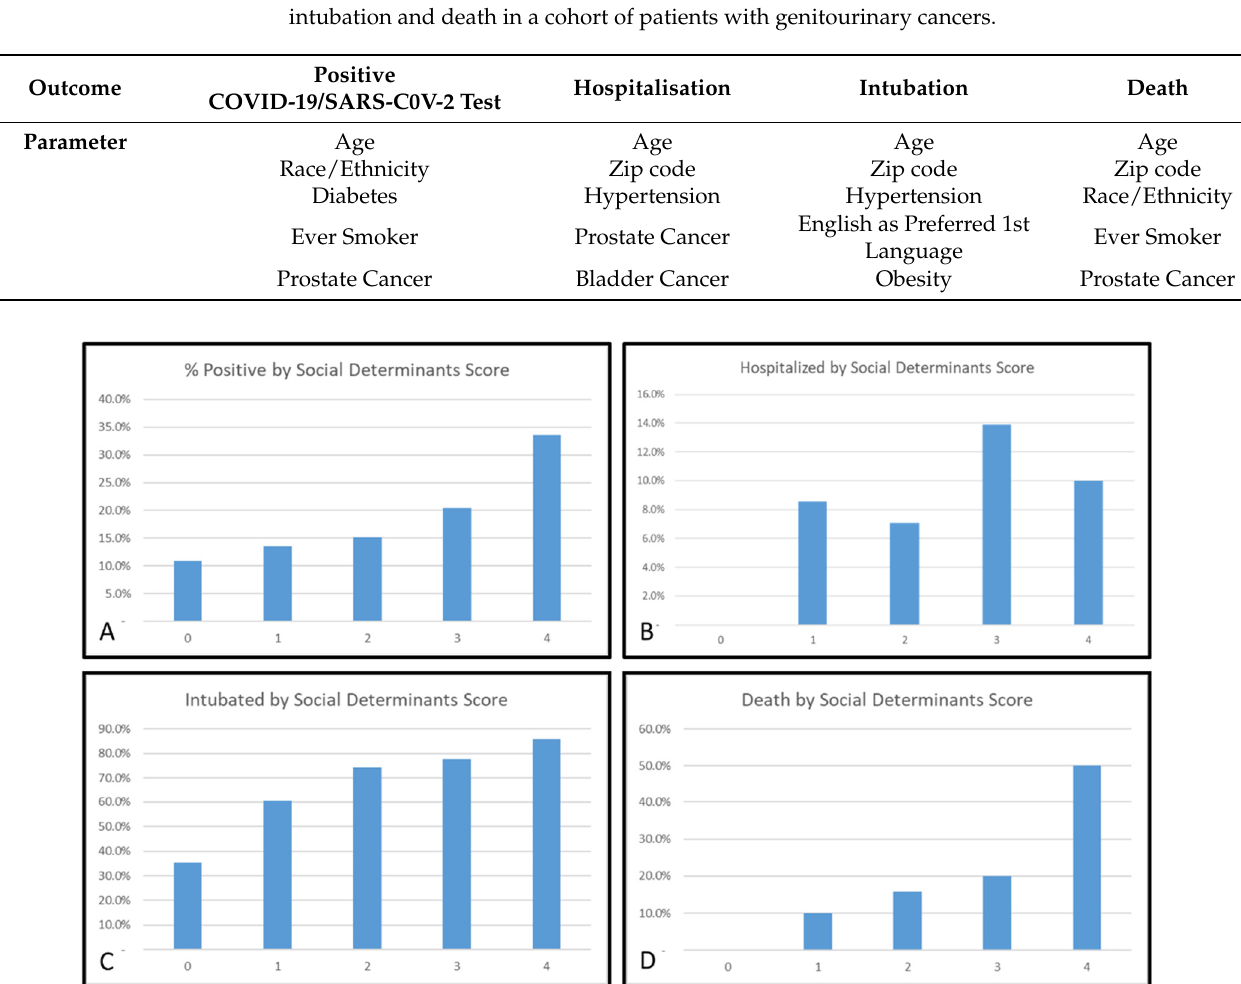
Figure 3. Relationship between social and medical determinants and COVID-19 outcomes: ( A ) positive COVID-19 test, ( B ) hospitalisation, ( C ) intubation and ( D ) mortality for patients with urologic cancers. A unique social determinant scale of ( A ) age, race/ethnicity, diabetes, current/former smoker, prostate cancer; ( B ) age, prostate cancer, hypertension, bladder cancer, zip code, ( C ) zip code, age, obesity, English as preferred 1st language, hypertension and ( D ) age, zip code, race/eth- nicity, prostate cancer, current/former smoker was created—in which each determinant was awarded 1 point. Of those urologic cancer patients who scored 4 points on these scales, >30% tested positive for COVID-19; 10% were hospitalised, >80% were intubated and >50% died. Table 2. The most parsimonious parameters as identified EFS analysis for each of this study’s out- comes: risk of testing positive for SARS-CoV-2 infection and COVID-19-related hospitalisation, in- tubation and death in a cohort of patients with genitourinary cancers.